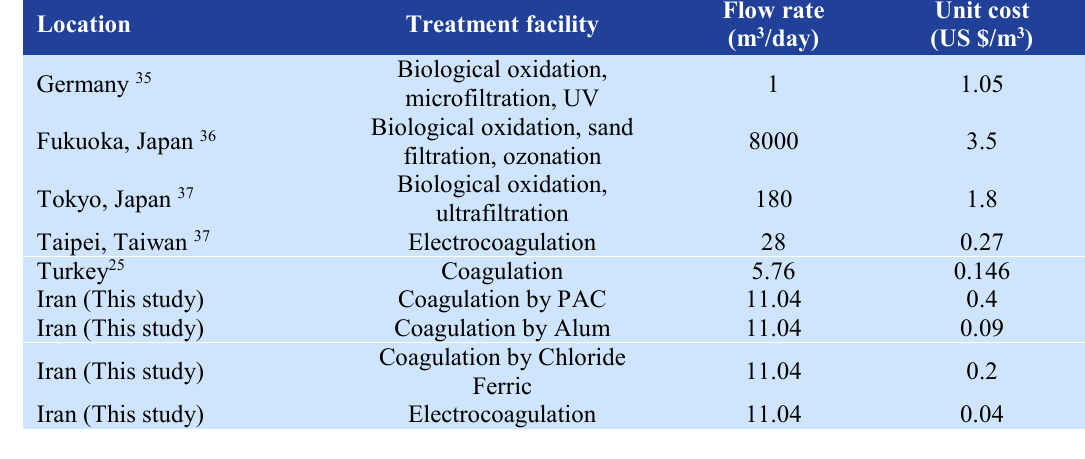
Table 3. Comparison of this with other cases in treatment method, flow rate, and unit